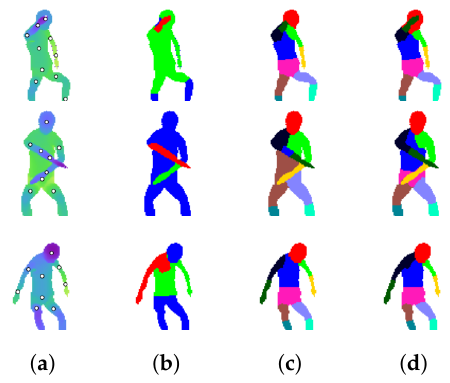
Figure 8. Dataset 2 [5]: Qualitative results. ( a ) Depth image with annotated part positions. ( b ) Arm segmentation. ( c ) Standard RW segmentation. ( d ) Our method. Table 5. Dataset 2 [5]: mean Jaccard index in % over all frames.